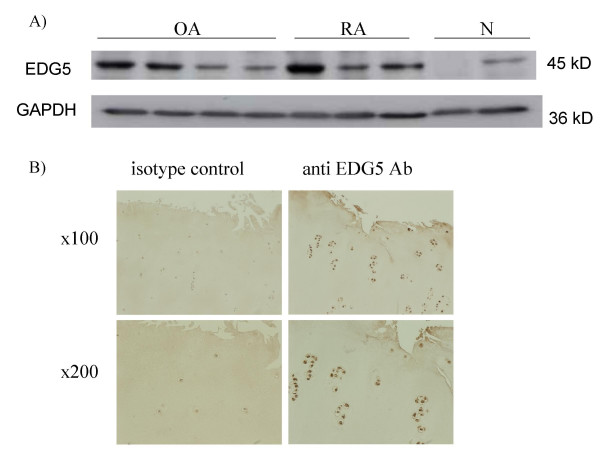
EDG5 expression in HAC. A) Western blot: Whole cell lysates from cultured HAC were subjected to immunoblotting. EDG5 was detected as a distinct band at 45 kD. B) Immunohistochemistry. Specimens of OA cartilage were subjected to analysis of EDG5 expression at protein level. The representative images are shown (N = 3).